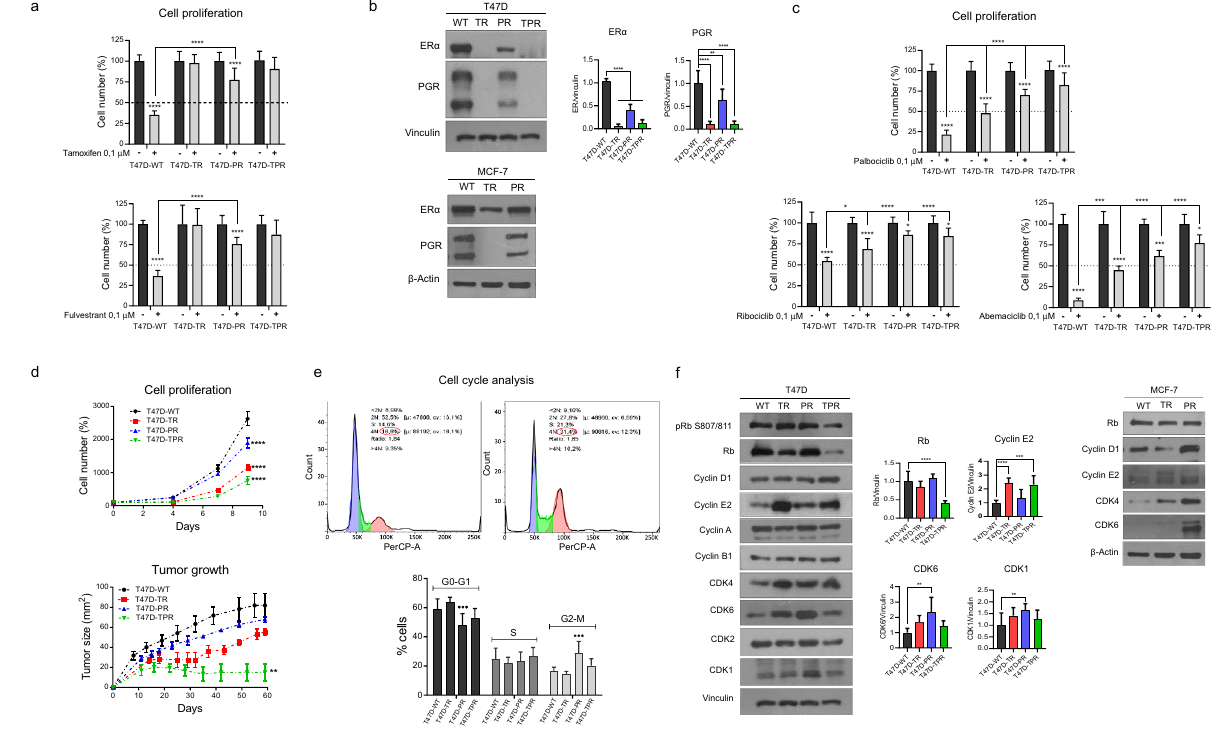
Figure 1. The resistant cells display alterations in proliferation and cell cycle. ( a ) Effect of ER inhibitors on cell proliferation. T47D cell variants were treated with 4-hydroxytamoxifen (0.1 µM), fulvestrant (0.1 µM) or vehicle for 7 days and counted at the end of the experiment. ****p < 0.0001. Data represent mean ± SD, two-way ANOVA followed by Tukey’s test (independent replicates n = 3, with 4 experimental replicates in each group). ( b ) Expression of hormone receptors. Protein lysates were obtained under basal conditions and analyzed by immunoblot with the indicated antibodies. For T47D variants, bands were quantified by densitometry and relativized to their loading control. **p < 0.01, ****p < 0.0001. Data represent mean ± SD, one-way ANOVA followed by Dunnett’s test (independent replicates n = 3, with 3 experimental replicates in each group). ( c ) Effect of CDK4/6 inhibitors on cell proliferation. T47D cells were treated with palbociclib (0.1 µM), ribociclib (0.1 µM), abemaciclib (0.1 µM) or vehicle for 7 days and counted at the end of the treatment. *p < 0.05, ***p < 0.001, ****p < 0.0001. Data represent mean ± SD, two-way ANOVA followed by Tukey’s test (independent replicates n = 3, with 4 experimental replicates in each group). ( d ) Cell proliferation and tumor growth. Top: Cells were cultured in the absence of drugs and quantified every 2 days. ****p < 0.0001. Data represent mean ± SD, two-way ANOVA followed by Dunnett’s test (independent replicates n = 3, with 4 experimental replicates in each group). Bottom: Tumor growth curves. 8 × 10 6 cells of each variant were injected subcutaneously in the lateral flank of NSG mice, previously implanted with silastic pellets containing 17β-estradiol (0.25 mg). **p < 0.01. Data represent mean ± SD, one-way ANOVA followed by Dunnett’s test at the end of the experiment (independent replicates n = 2, with 3 experimental replicates in each arm of treatment). Representative curve of two. ( e ) Cell cycle analyses. T47D cells were stained with propidium iodide and analyzed by flow cytometry. ***p < 0.001. Data represent mean ± SD, one-way ANOVA followed by Dunnett’s test (independent replicates n = 4, with 4 experimental replicates in each group). ( f ) Expression of cell cycle proteins. Protein lysates were obtained under basal conditions and analyzed by immunoblot with the indicated antibodies. For T47D variants, bands were quantified by densitometry and relativized to their loading control. **p < 0.01, ***p < 0.001, ****p < 0.0001. Data represent mean ± SD, one-way ANOVA followed by Dunnett’s test (independent replicates n = 2, with 3 experimental replicates in each group). Original blots/gels are presented in Supplementary Material, unprocessed western blots